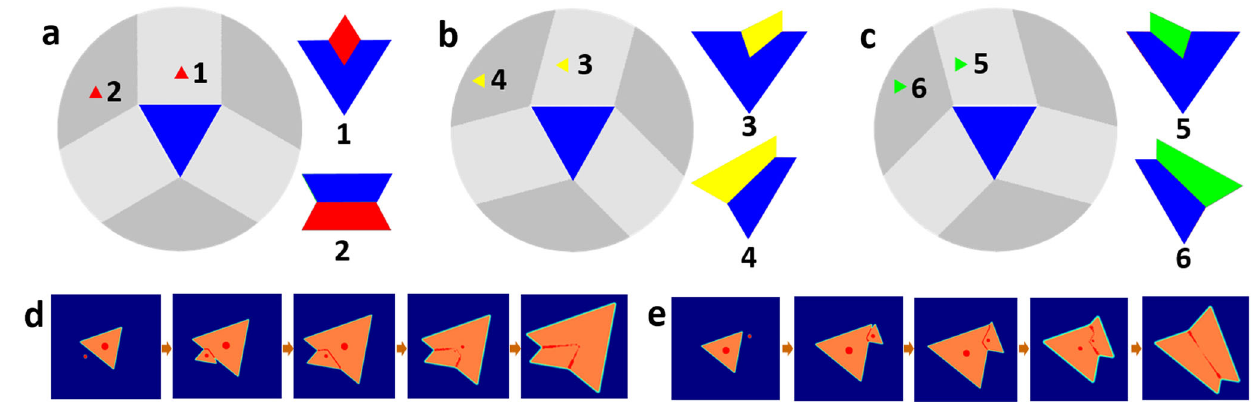
Fig. 4 Coalescence of two triangular grains on a fourfold symmetric substrate. a – c Topography diagrams for the coalescence of two triangular grains with an anti-clockwise misorientation angle of 60 o , 30 o , and 90 o , respectively. The blue triangular grain is chosen as the reference. Light gray and dark gray areas denote where the second triangular grain is nucleated with respect to the fi rst one, respectively. Shapes 1 – 2, 3 – 4, and 5 – 6 show the steady-state polycrystals formed from the coalescence between two grains with different misorientation angles. d , e PFT simulations showing the coalescence processes of two triangular grains with a 30 o misorientation angle to form a polycrystal with shape 3 and shape 4, respectively. The fourth and fi fth panels in ( d , e ) are zoomed out for a better